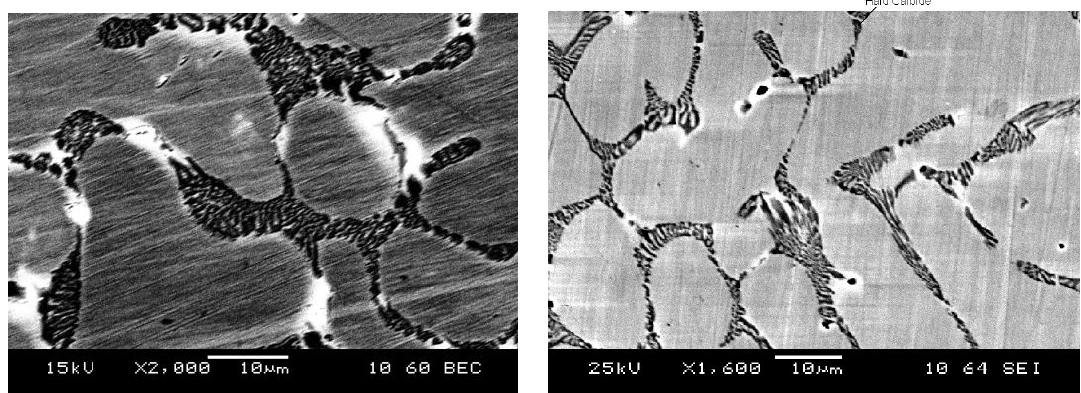
Figure 10: Metallographic microstructure of Stellite